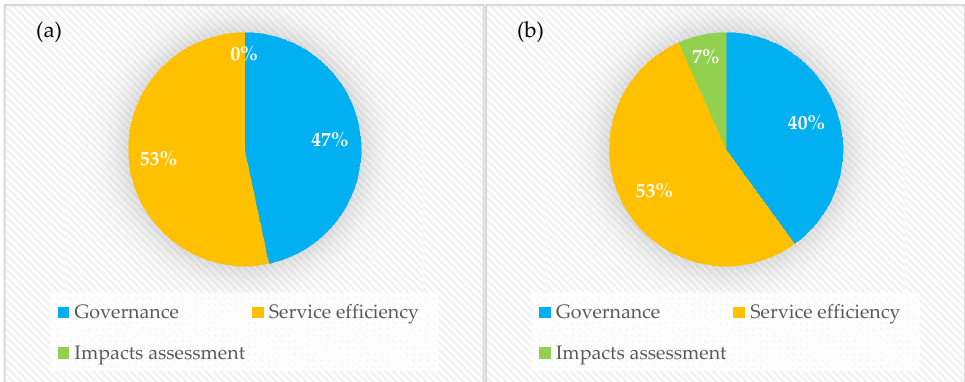
Figure 2. ( a ) Topic coverage IMC (the most cited articles); ( b ) topic coverage IMC (newest articles).